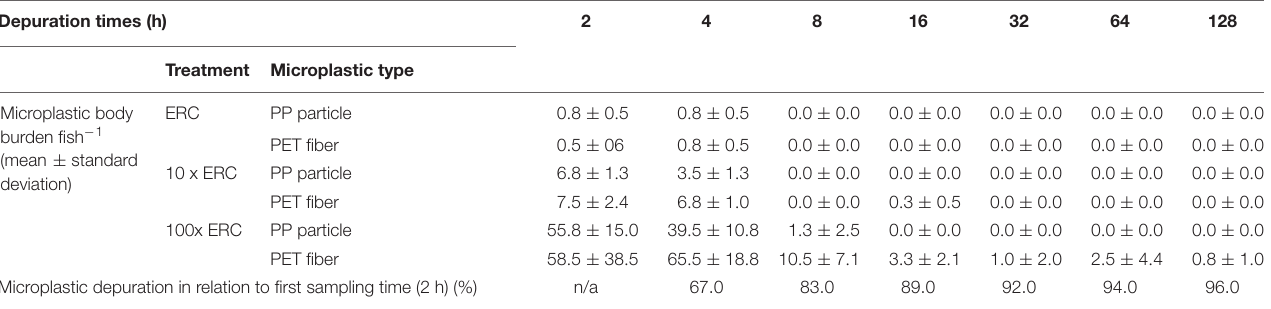
TABLE 4 | Mean microplastic body burden fish − 1 (absolute number ± standard deviation; n = 4 fish per treatment and depuration time) in three treatment groups ( n = 84 tanks) during a single exposure of adult damselfish Pomacentrus amboinensis to blue polypropylene (PP) particles and polyester (PET) fibers in a controlled laboratory